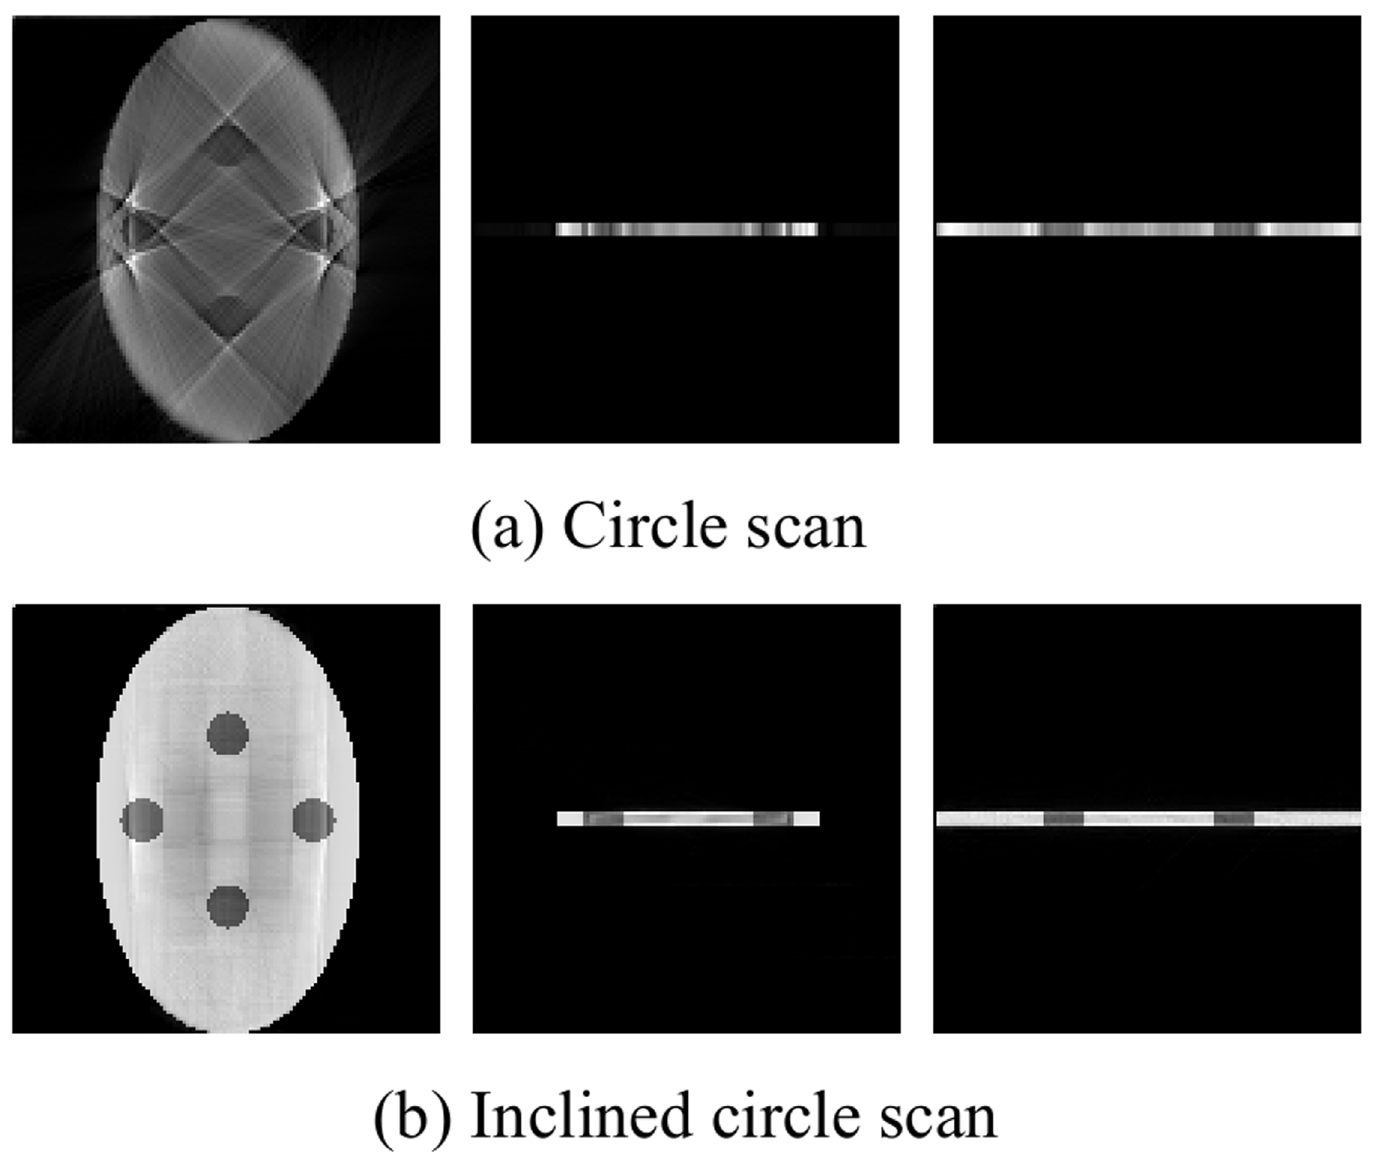
Fig 8. Slices of reconstructed image with tabular